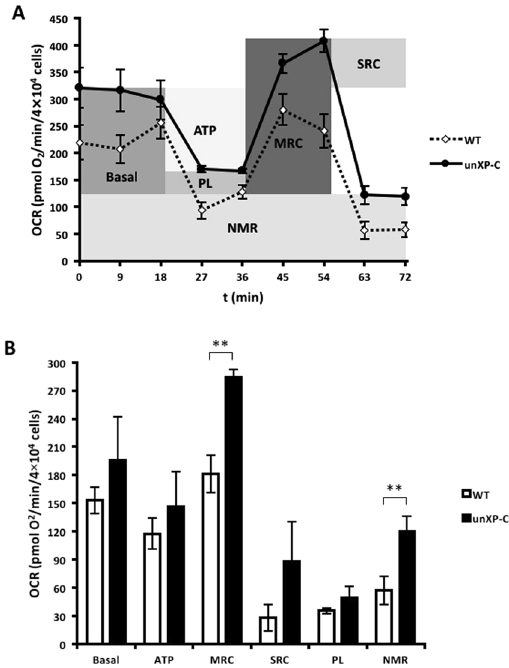
Figure 2. Oxygen consumption is not altered in intact XP-C fibroblasts. ( A ) O 2 consumption was measured in MRC-5 (WT) and XP4PA (unXP-C) as described, using 4 × 10 4 cells/well in XF Assay Medium containing 10 mM glucose, with the subsequent additions of 1 µ M oligomycin (ATP synthase inhibitor), 200 nM CCCP (uncoupler) and 1 µ M rotenone plus AA (CI and CIII inhibitors). The trace represents the mean ± SD of three independent experiments and a schematic illustration of respiratory parameters. ( B ) Calculated respiratory parameters: Basal (base line OCR minus rotenone plus AA OCR), ATP (ATP-linked OCR – base line OCR minus oligomycin OCR), MRC (maximum respiratory capacity – CCCP OCR minus rotenone plus AA OCR), SRC (spare respiratory capacity – CCCP PCR minus base line OCR), PL (proton leak – oligomycin OCR